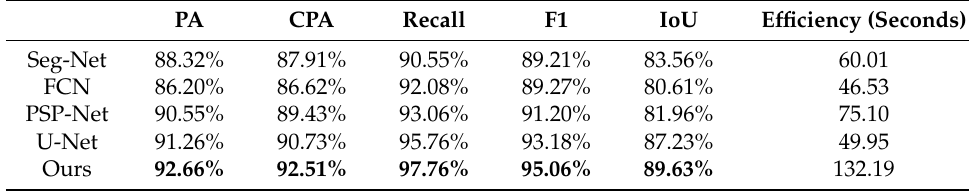
Table 4. Cloud detection